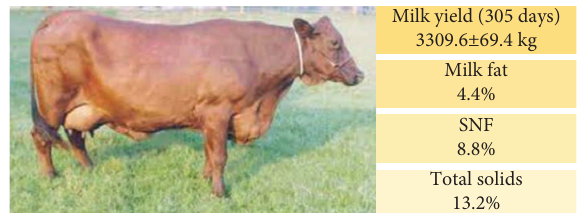
Figure 1: Vrindavani cow and its milk production with composition. Table 1: Details of feeding schedule and adult livestock unit followed at IVRI cattle and bufalo farm, Izatnagar. Age